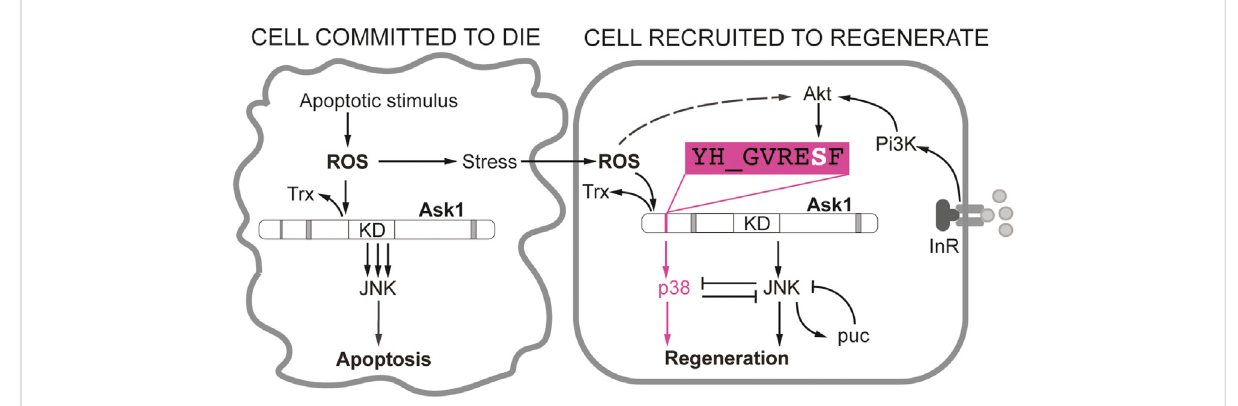
FIGURE 2 Different requirement of JNK and p38 in Drosophila wing disc cells during apoptosis and regeneration. Apoptotic stimulus produces ROS that promote the dissociation of the thioredoxin (Trx) from Ask1. As a consequence, the activity of the Ask1 kinase domain is enhanced and JNKK will be phosphorylated and eventually the cell will irreversibly enter into apoptosis (Cell committed to die). The adjacent healthy cells will be sensitive to propagated ROS from the apoptotic cell, albeit in much lower levels, and moderately activate Ask1 (Cell recruited to regenerate). Ask1 can activate JNK in low levels or transiently until puckered ( puc ) attenuates JNK. In addition, the JNK-p38 antagonism could also attenuate JNK in the regenerating cell. This is key to maintain the viability of the regenerating cell. Activation of the Pi3K/Akt by nutrients or insulin signaling will result in phosphorylation of the Ser residue of YH_GVRESF Ask1 consensus. This signal is crucial for the activation of p38 but not JNK. Akt is also sensitive to ROS, likely through PTEN inactivation (dotted